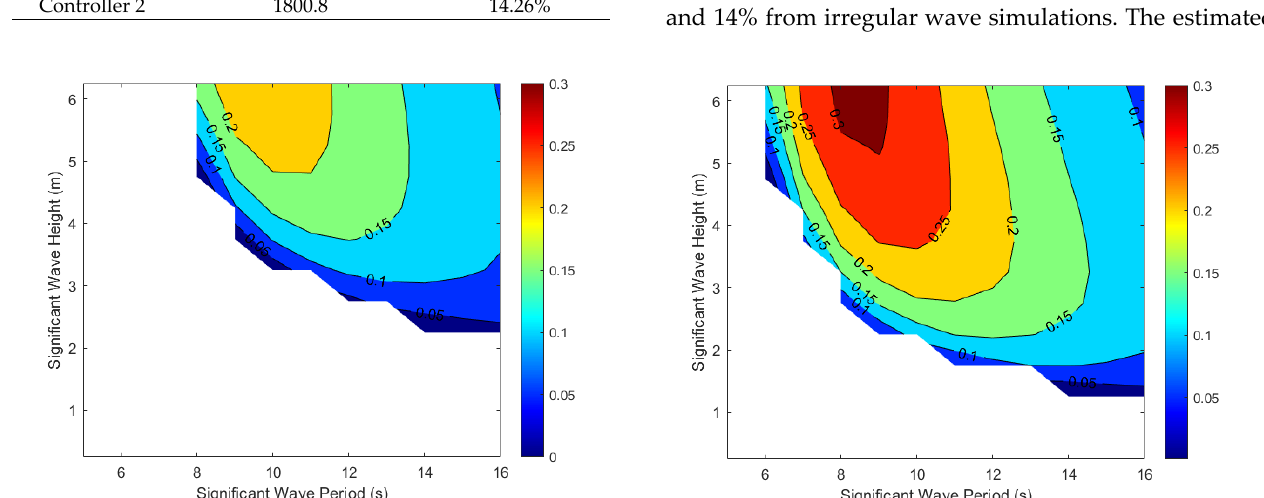
Fig. 15: Efficiency of power generation after drag losses were considered for irregular wave simulations. Left, controller 1. Right, controller 2.